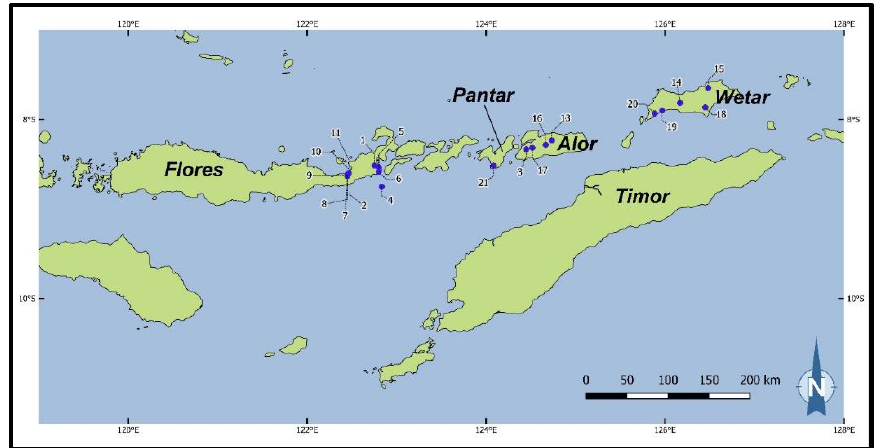
Figure 2. Geographic locations of E. urophylla natural stand provenances in Indonesia from which the genetic material included in the trials of the first cycle breeding population originated—the numbers linked to blue dots indicate the locations of the numbered provenances listed in Table 1.